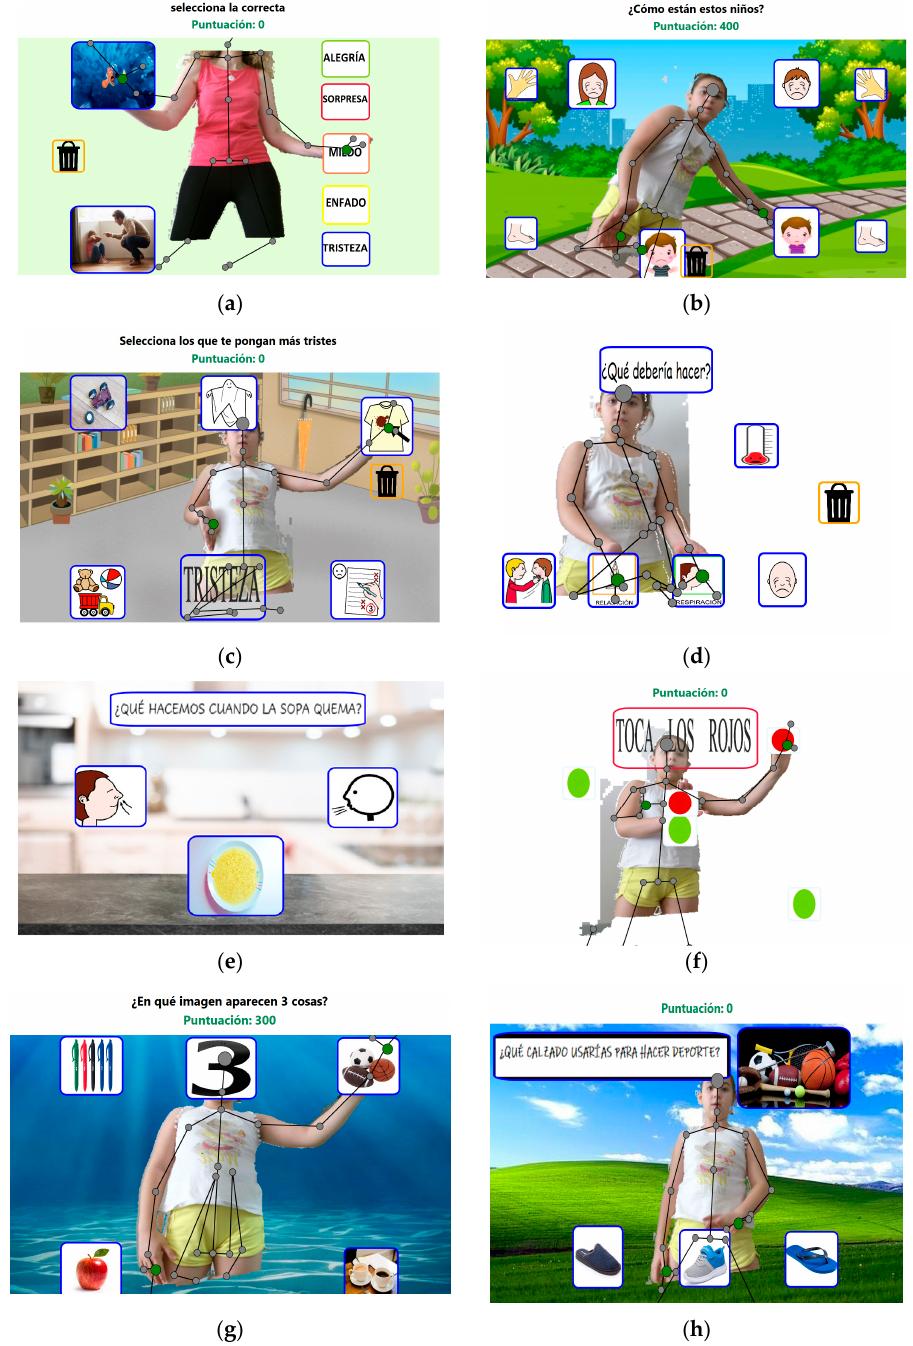
Figure 2. Example of tasks with “SR-MRehab: Un colegio emocionante”: ( a – c ) Emotional Perception, ( d , e ) Emotional Regulation; ( f ) Cognitive Regulation: inhibitory control; and ( g , h ) Cognitive Regulation: Reasoning and problem solving.